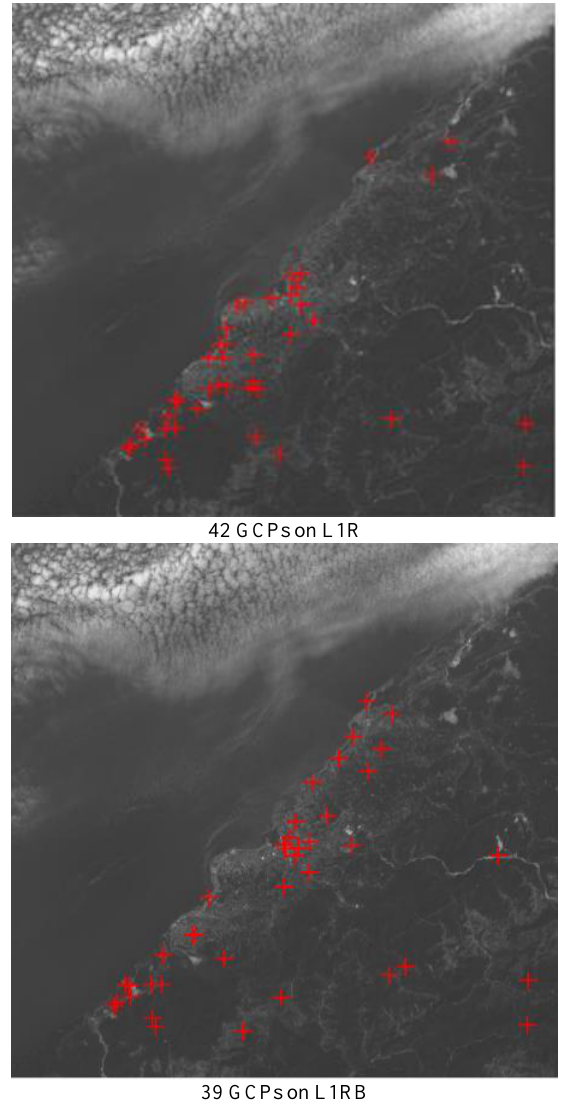
Figure 4. Sample GCP distribution.